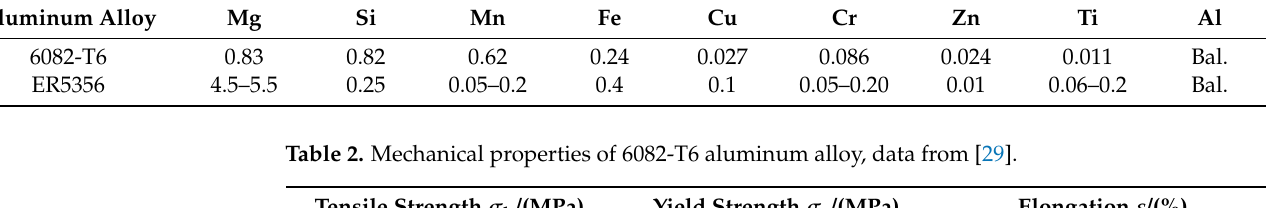
Table 1. Chemical compositions of the workpiece and wire, data from [27,28]. Aluminum Alloy